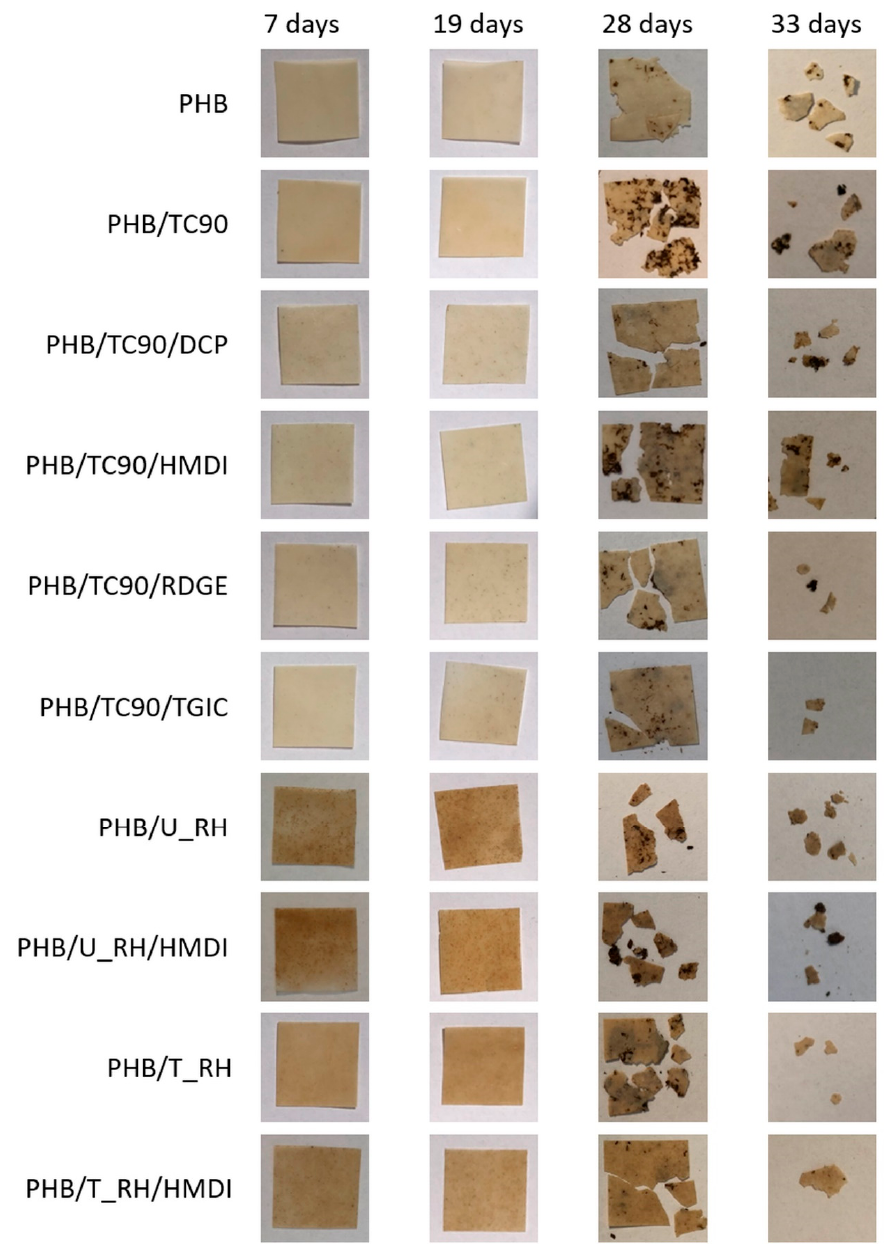
ff erent composting